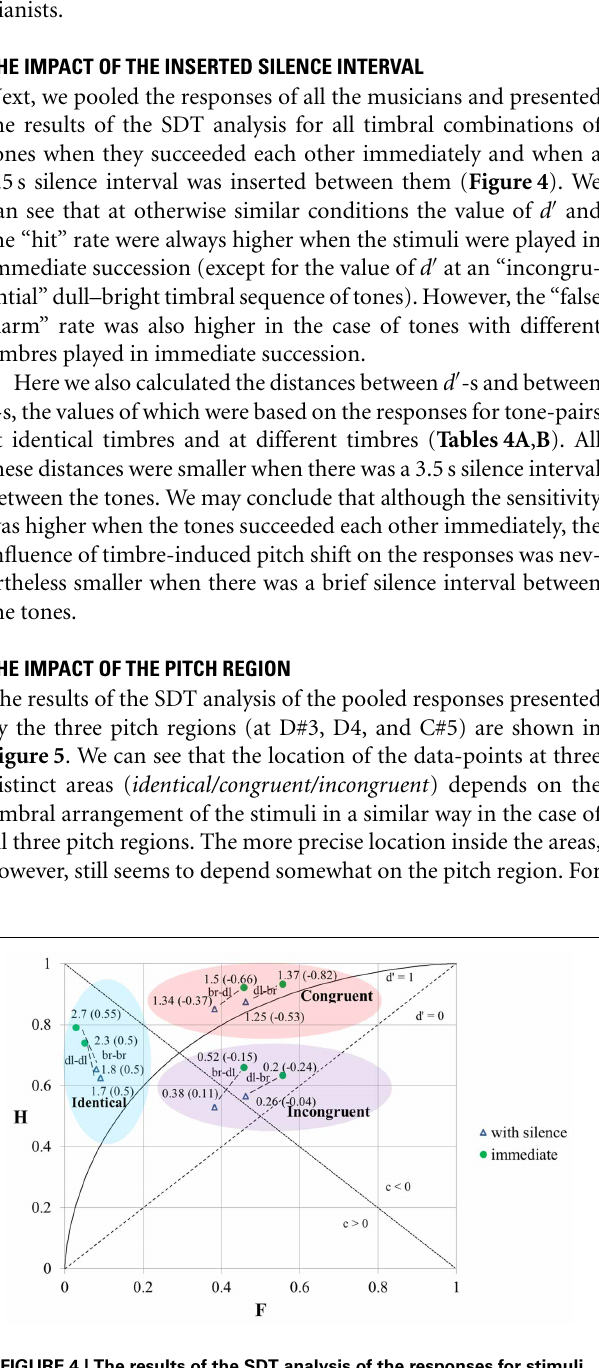
FIGURE 4 | The results of the SDT analysis of the responses for stimuli with immediate succession and with a 3.5s silence interval between the individual tones. H, “hit” rate; F, “false alarm” rate; br, bright timbre; dl, dull timbre. The numbers at the data-points correspond to the values of d (cid:2) (the first number) and c (the number in